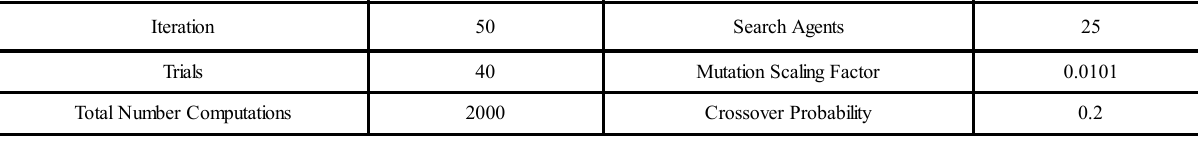
FIG. 7. COMPARISON OF FUEL COST FOR 15 UNIT TEST SYSTEM CONSIDERING LOSSES AND PROHIBITED OPERATING ZONE WITH THE DEMAND OF 2630 TABLE 7. LIST OF PARAMETERS TAKEN FOR TEST SYSTEM-I